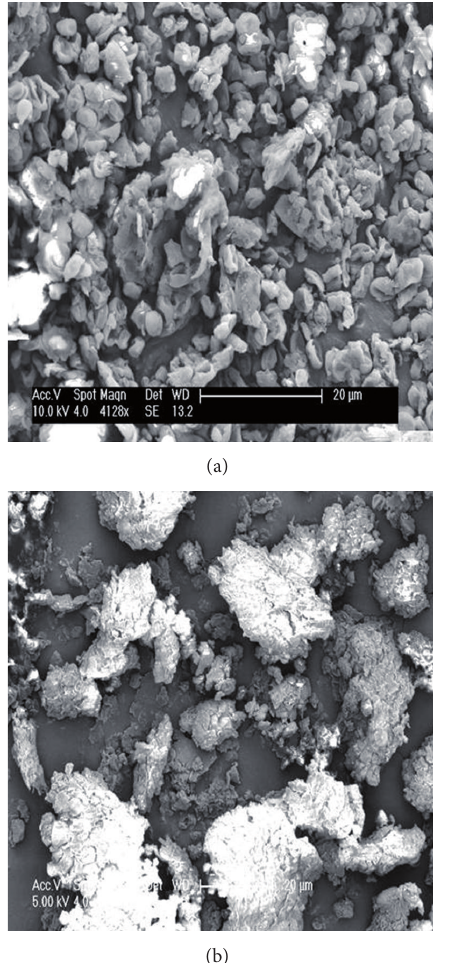
F 2: SEM micrographs of T. viride biomass surface, (a) before adsorption of Ni(II) ions and (b) aer adsorption of Ni(II) ions.